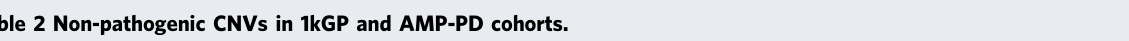
Table 2 Non-pathogenic CNVs in 1kGP and AMP-PD